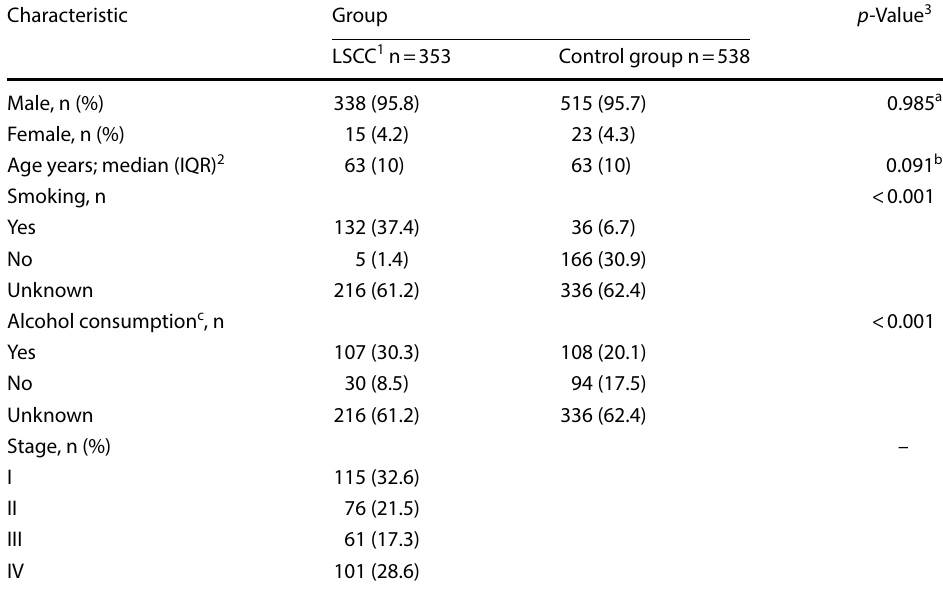
Table 1 Demographic characteristics of the